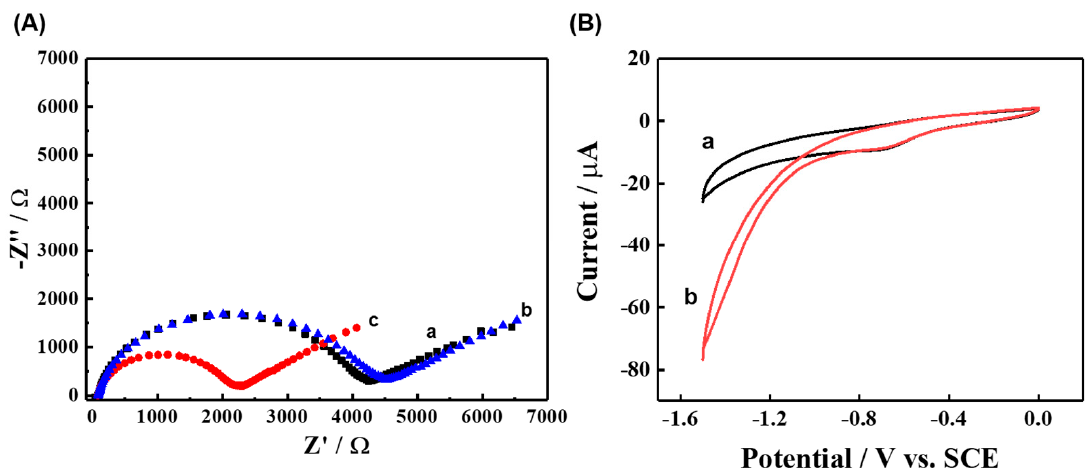
Figure 9. ( A ) Nyquist plots of TCPP-Zn-(S)-BINOL/GCE in 0.1 M PBS containing 5.0 mM [Fe(CN) 6 ] 4 − /3 − before (a) and after its incubation with 2 mM D-Tyr (b) and L-Tyr (c). ( B ) Cyclic voltammograms of L-Tyr/GCE in 0.1M HEPES containing 0.3 M KCl in the absence (a) and presence (b) of 12 mM H 2 O 2 .